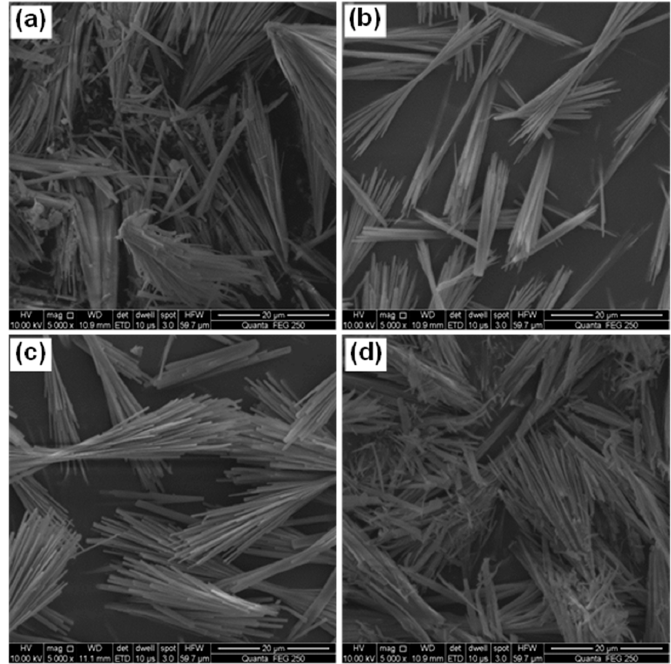
Figure 13. Morphologies of whiskers obtained at different hydrothermal durations ( a ) 0.5 h; ( b ) 2 h; ( c ) 4 h; ( d ) 7 h.